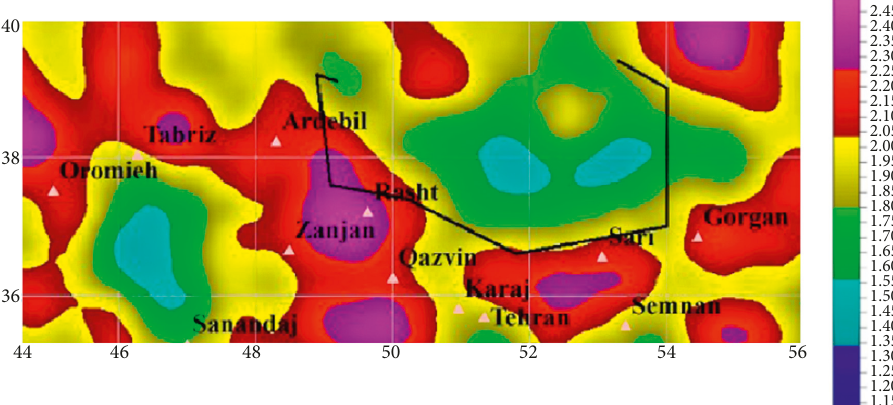
Figure 6: Map of 90% quintile of distribution of maximum values of log ( A